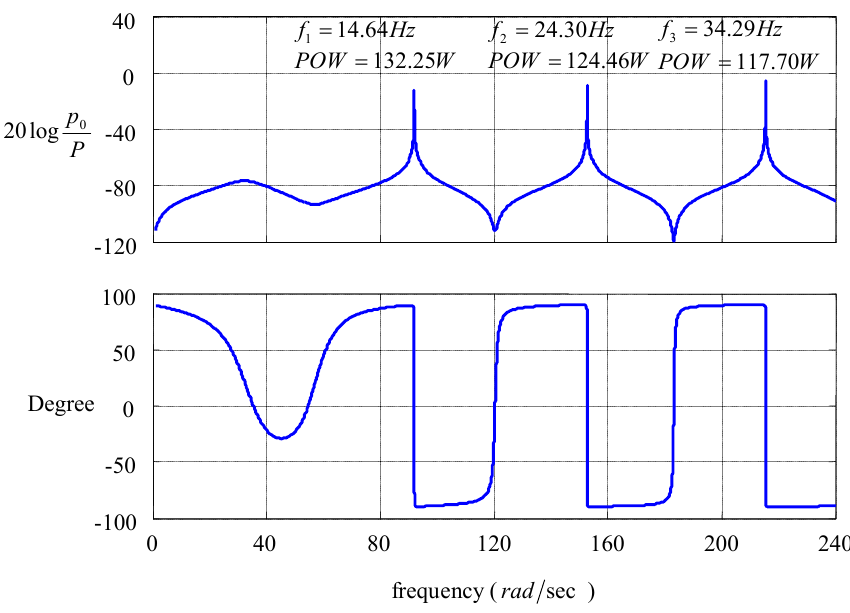
Figure 5. System identification in frequency